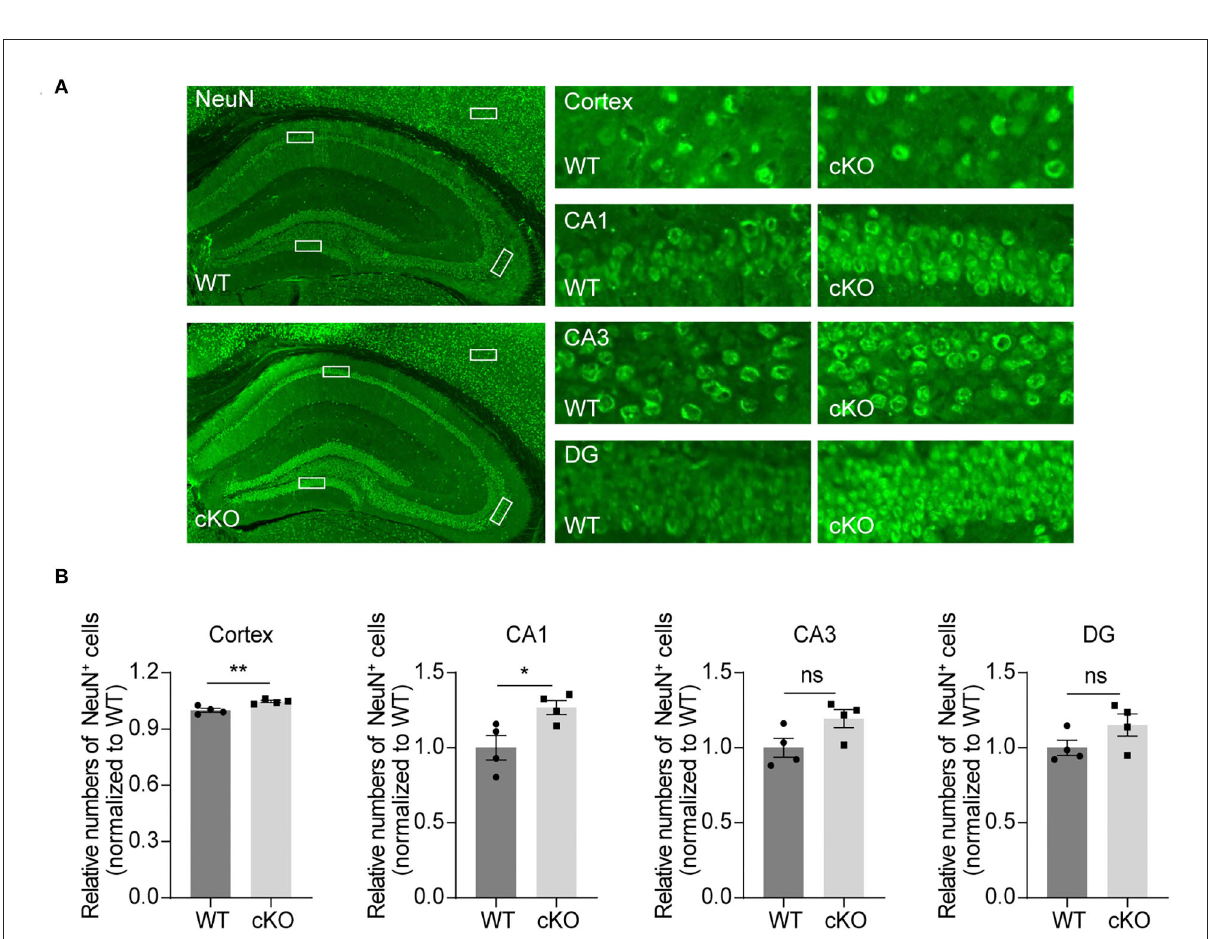
FIGURE5 Increased neurons in the CA1 region and the cerebral cortex. (A) Representative fluorescent images of NeuN in the hippocampus and the cerebral cortex. The dashed box indicates the representative areas of the cerebral cortex, CA1, CA3, and DG. The scale bar is 500 µ m. The representative enlarged images of these areas are shown on the right, and the scale bar is 50 µ m. (B) Quantification of NeuN in the cerebral cortex ( p = 0.0084, t = 3.85), CA1 ( p = 0.0294, t = 2.845), CA3 ( p = 0.0678, t = 2.224) and DG ( p = 01413, t = 1.693), unpaired two-tailed t -tests, n = 4. * p < 0.05, ** p < 0.01, ns indicates no significance. All data are displayed as means ±